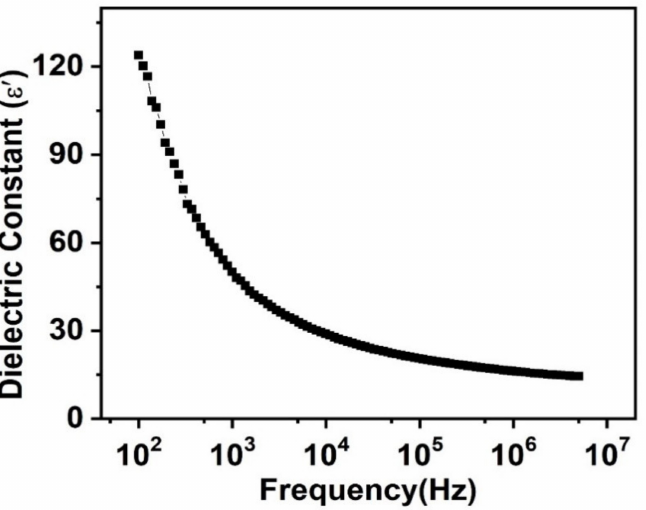
Figure 5. Change of dielectric constant of prepared PbSe along with altering